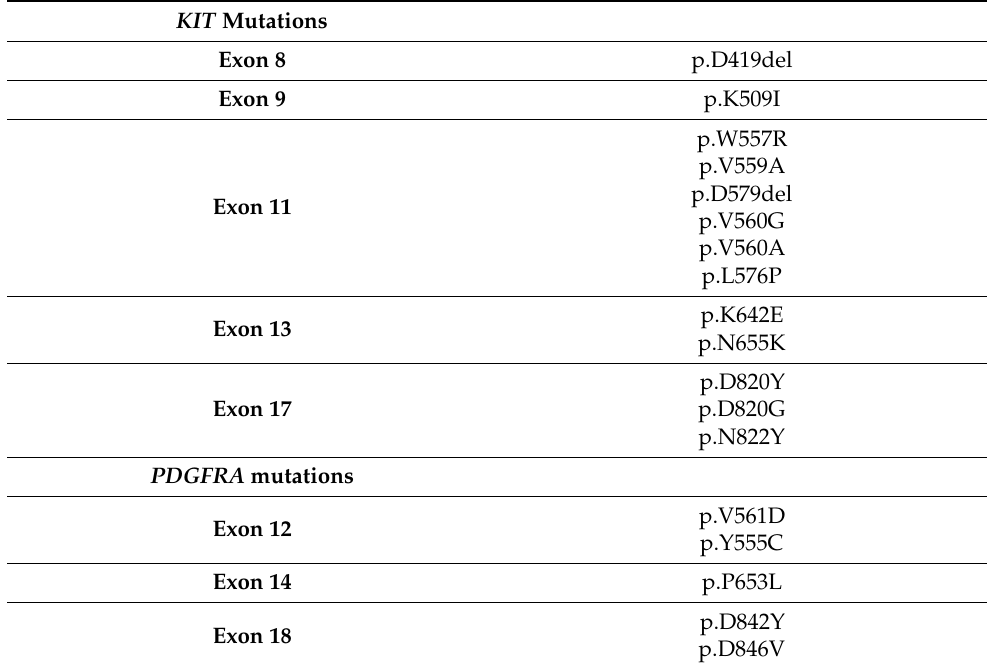
Table 3. Most common KIT and PDGFRA mutations found in familial GIST. KIT Mutations Exon